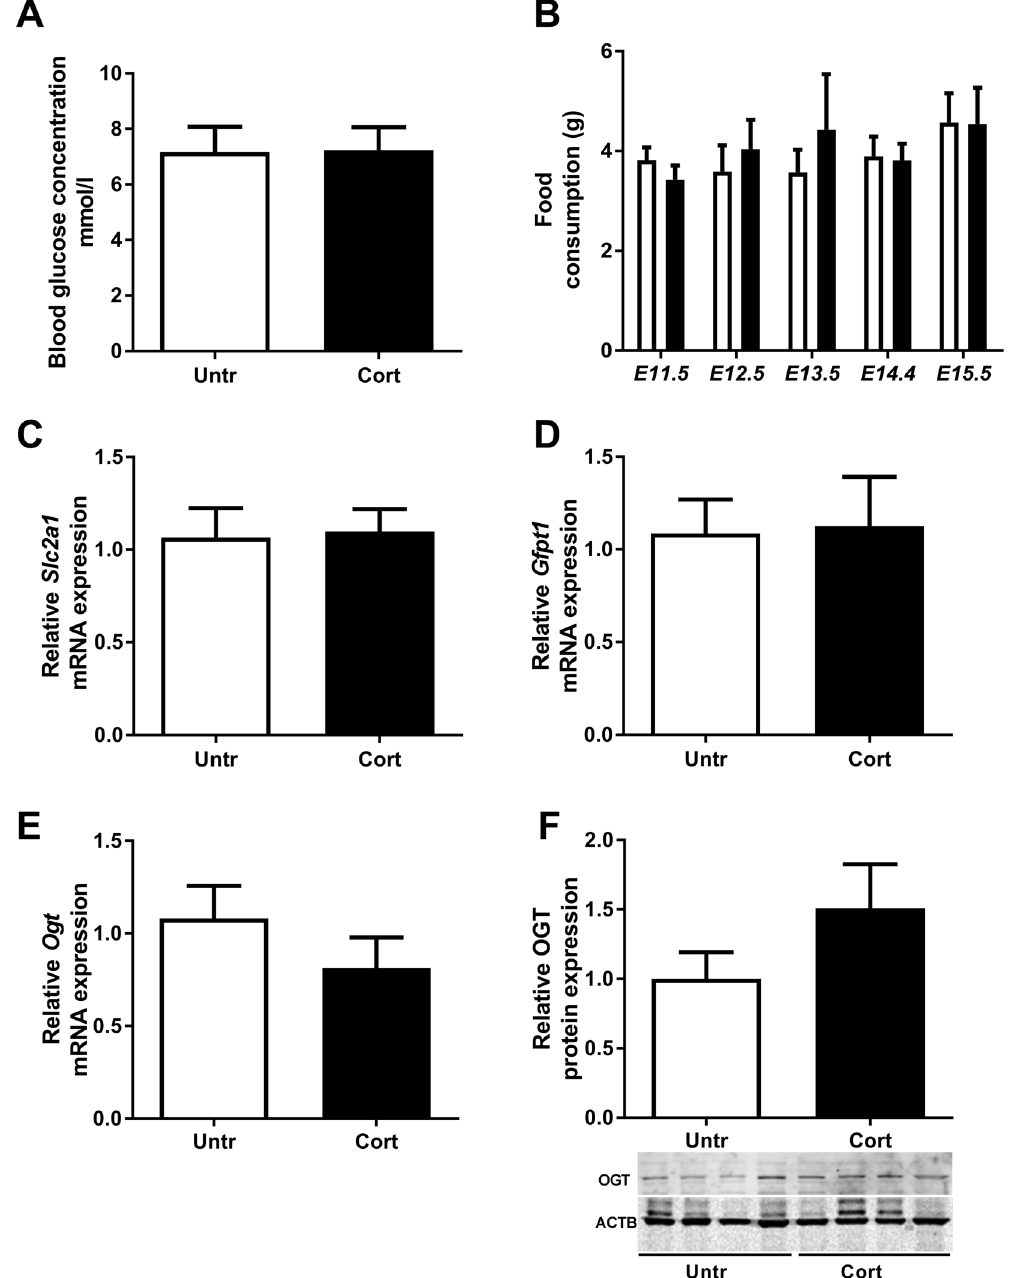
Figure 1. The effects of corticosterone exposure (Cort-black bars) on ( A ) maternal blood glucose concentrations, ( B ) maternal food consumption, ( C ) hepatic mRNA expression of solute carrier family 2, facilitated glucose transporter member 1 ( Slc2a1 or Glut1), ( D ) Glutamine-fructose-6-phosphate-transaminase 1 ( Gfpt1 ) and ( E ) O-linked β -N-Acetylglucosamine (OGT) compared to untreated (Untr-white bars) controls. Protein expression of hepatic OGT was also investigated in Untr or Cort exposed dams ( F ). Data represented as mean + SEM. Maternal blood glucose concentrations and hepatic gene expression results were analysed by two-tailed t- tests (n = 6–7). Maternal food consumption was measured daily from E11.5 until E15.5 and data analysed using a one way ANOVA. Protein expression was examined by western blot with β -Actin (ACTB) as a loading control, normalised to untreated control and analysed using a two-tailed t-